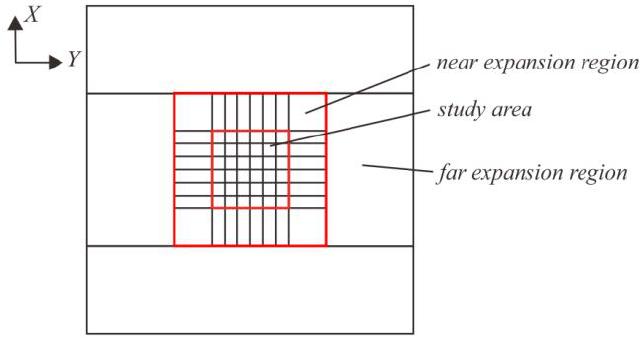
Figure 4. Vertical view of the expansion zone.